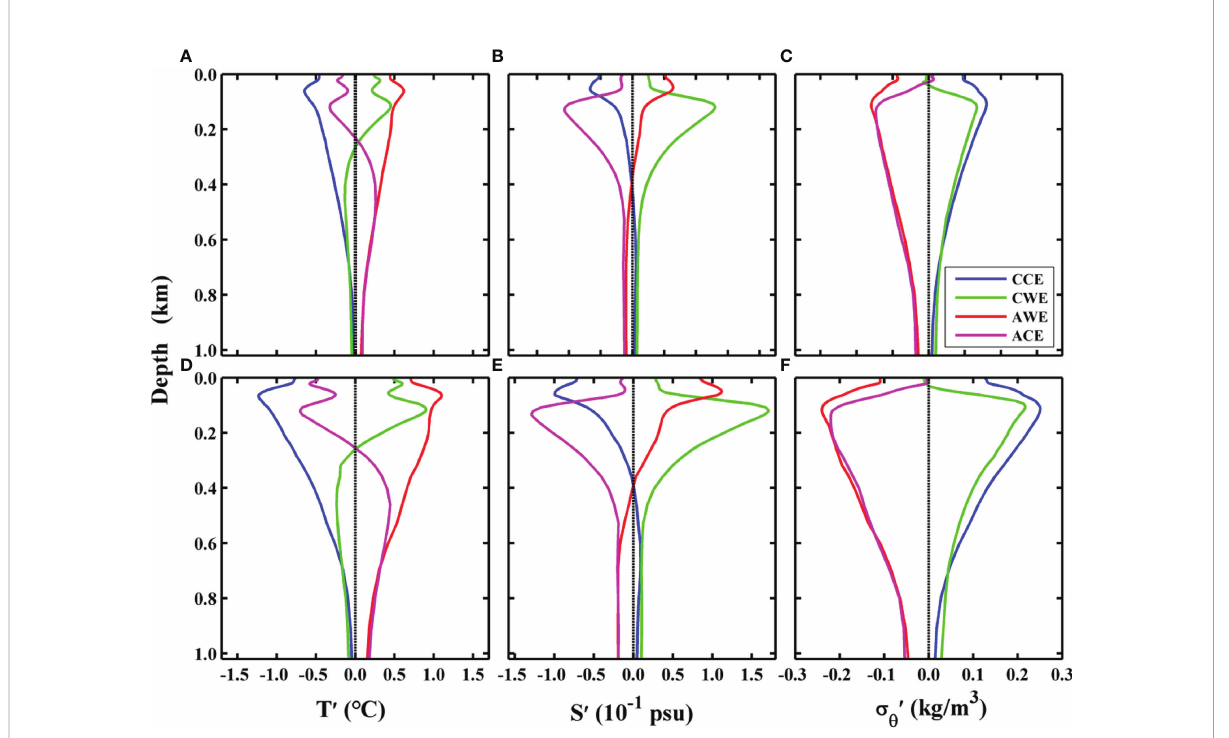
FIGURE 9 Vertical distribution of the four types of eddies-modulated temperature (A , D , units: °C ) , salinity (B , E , units: 10 -1 psu ) , and potential density anomalies (C , F , units: kg/m 3 ) . Sub fi gures (A – C) show the results averaged within a one-time eddy radius, and (D – F) show the results averaged within 0.5 times eddy radius. The blue, red, green, and magenta lines represent cyclonic cold-core, anticyclonic warm-core, cyclonic warm- core, and anticyclonic cold-core eddy,